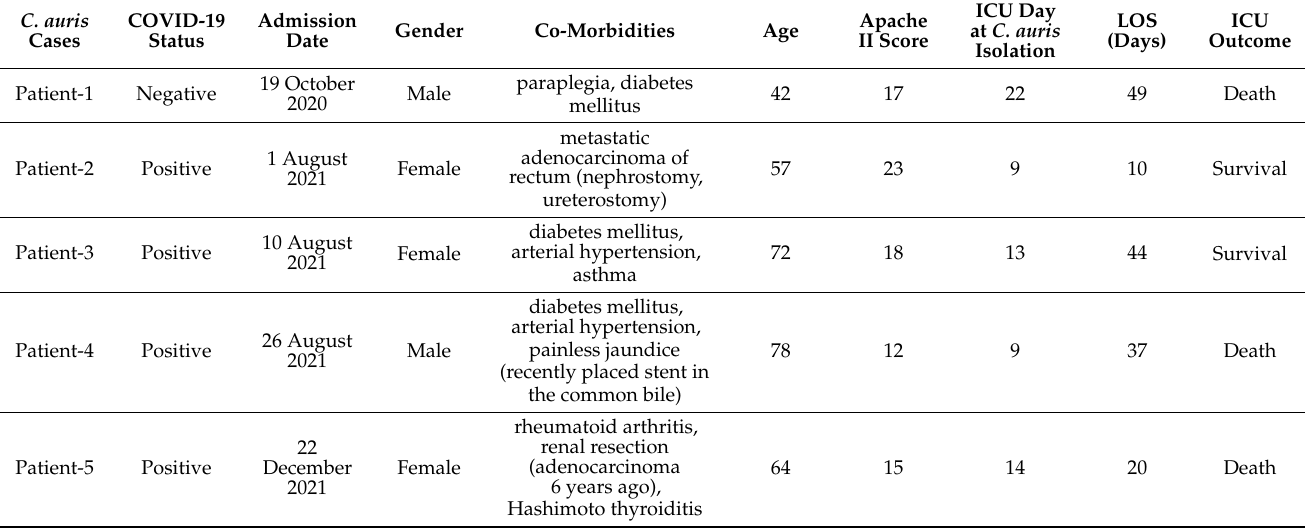
Table 1. Demographic and clinical characteristics of ICU patients with C. auris